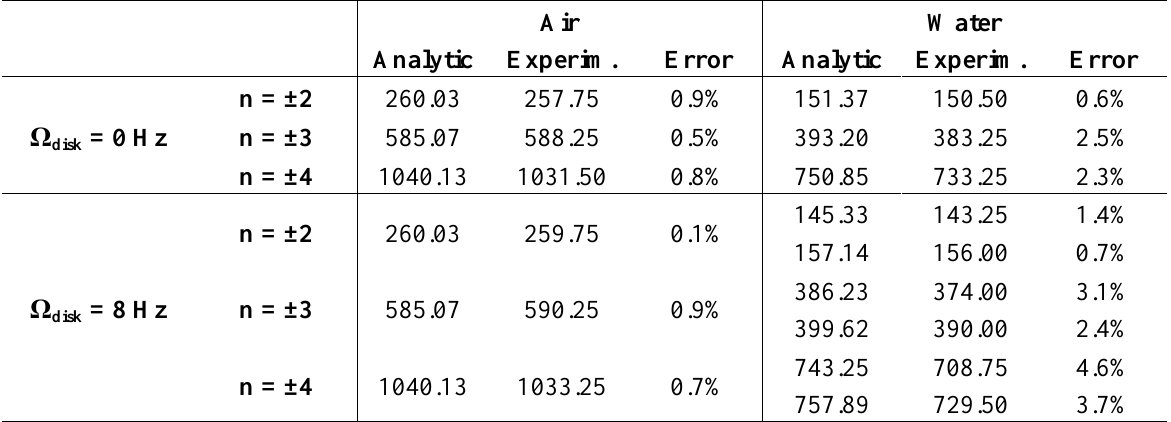
Table 2. Natural frequencies (Hz) of the stationary and rotating disk in air and water. Analytical and experimental